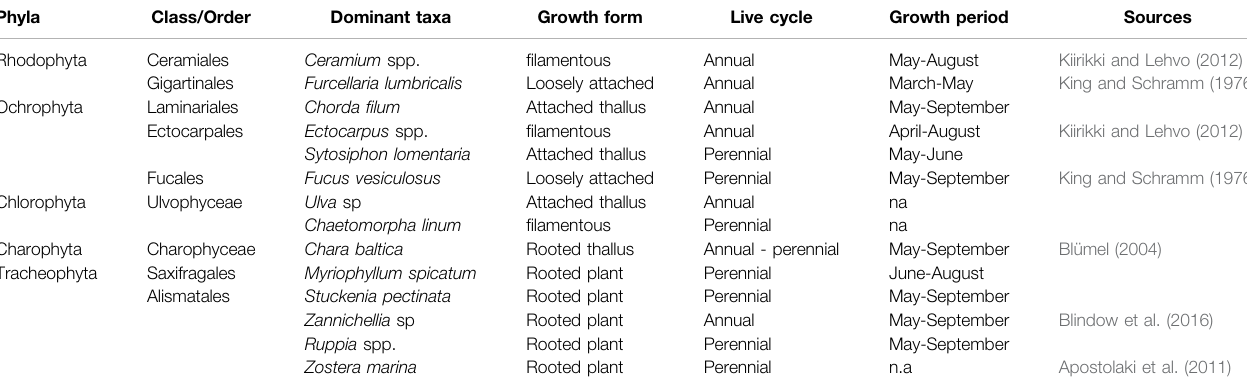
TABLE 1 | Complete list of macrophytobenthic species sampled in Vitter Bodden and Grabow from March to December 2017. Phyla